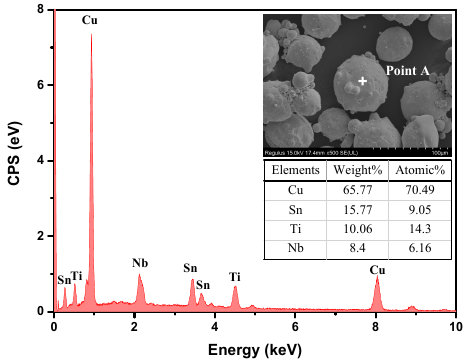
Figure 1. Microstructure and elements composition of TC